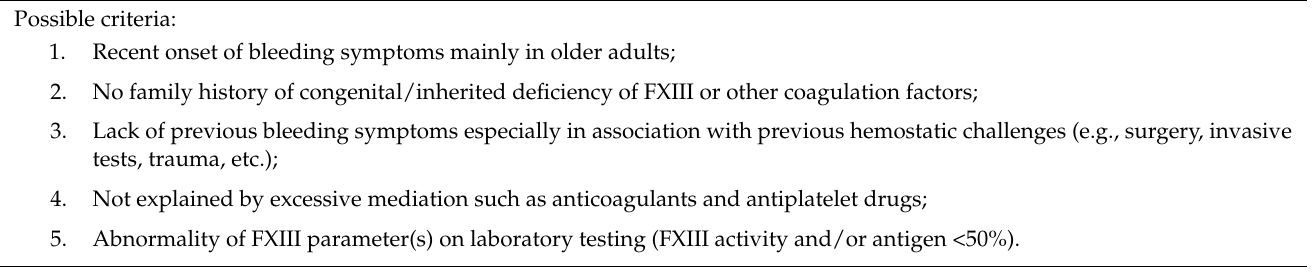
Table 1. The diagnostic criteria for autoimmune factor XIII deficiency with bleeding symptoms used in Japan